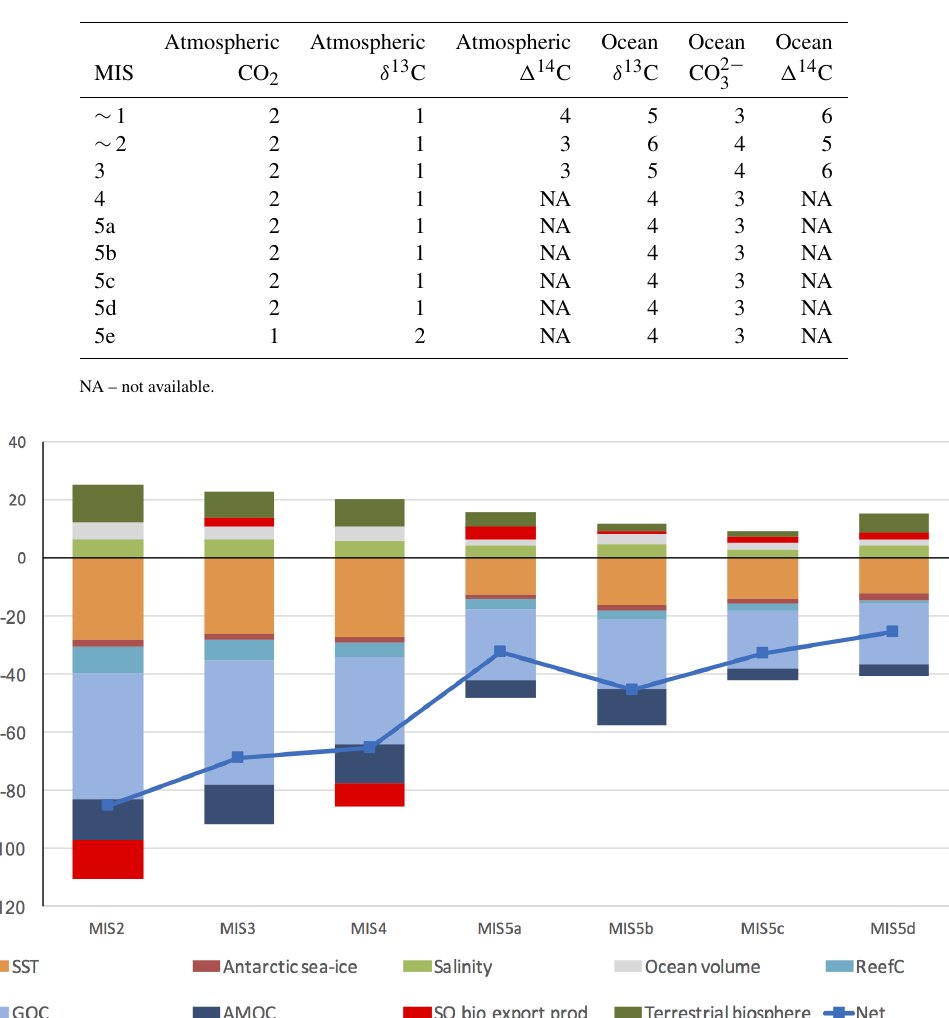
Figure 14. Impacts on atmospheric CO 2 concentration of model parameters in the model–data experiment results, from the last interglacial period (MIS 5e) to the Last Glacial Maximum (MIS 2). SST: sea surface temperature; ReefC: shallow carbonate production or dissolution; GOC: global ocean circulation; AMOC: Atlantic meridional overturning circulation; SO Bio Export: Southern Ocean biological export